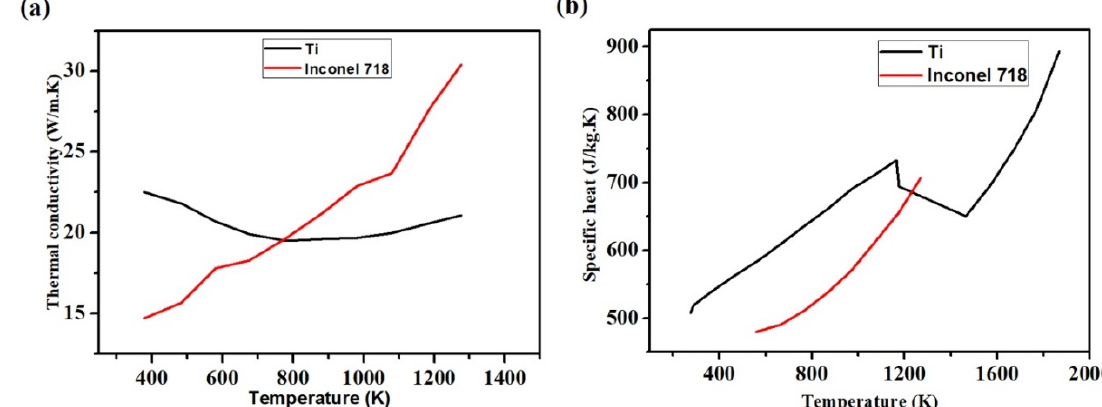
Figure 2. Temperature-dependent ( a ) thermal conductivity and ( b ) specific heats of Ti and Inconel 718 [44,59–61]. Table 2. Material properties of Ti and Inconel 718 used in the present work [61–63]. Parameter